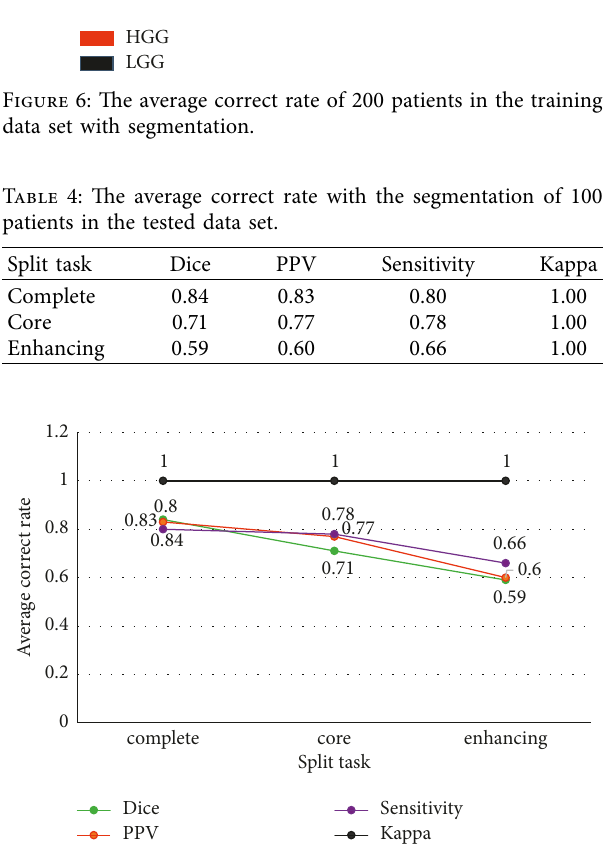
Figure 7: The average correct rate with the segmentation of 100 patients in the tested data set.